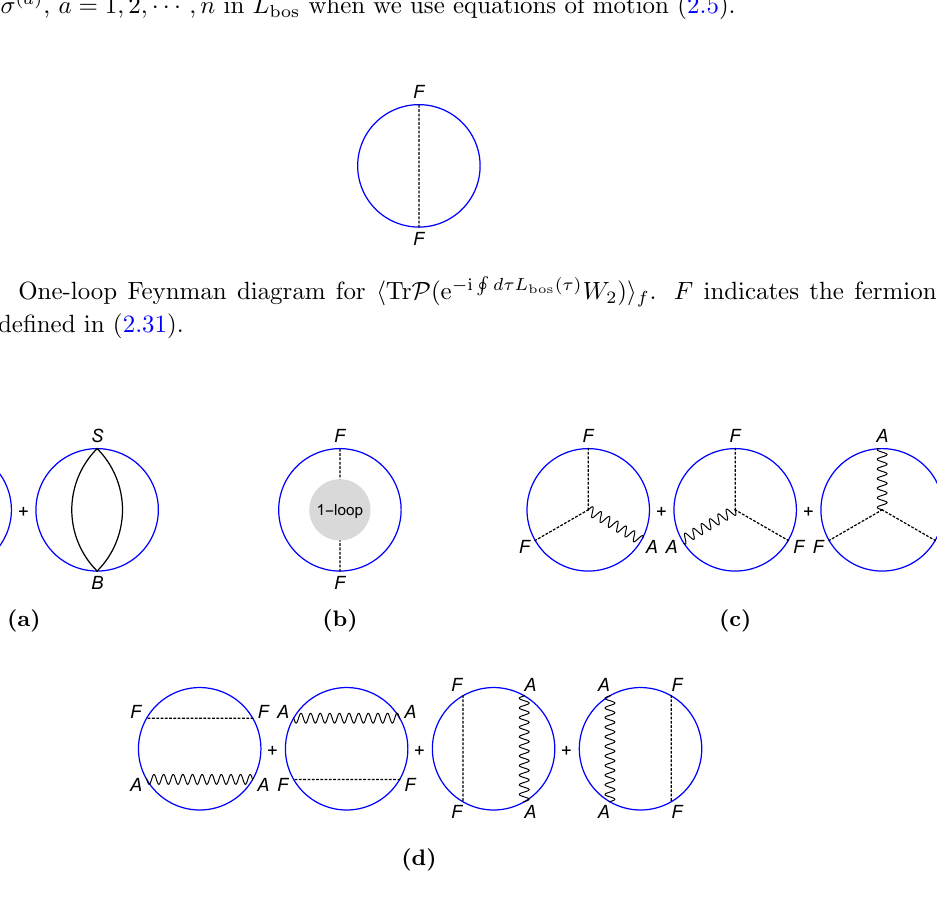
Figure 6. Two-loop Feynman diagrams for h Tr P (e (cid:0) i H d(cid:28)L bos ( (cid:28) ) W 2 ) i f . Here B indicates the bosonic quantities de(cid:12)ned in (2.31).